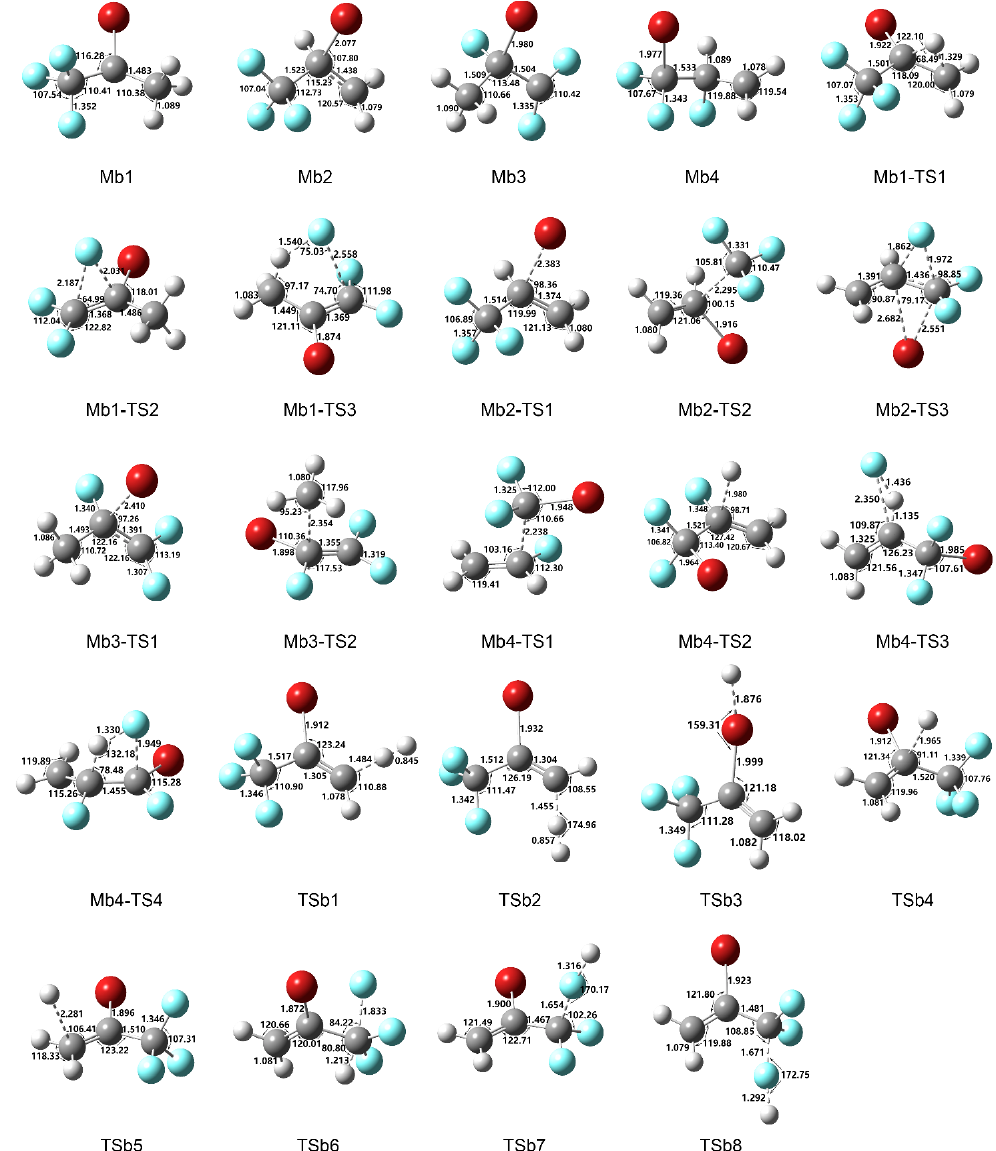
Figure 2. Optimized geometries of intermediates and transition states in 2-BTP + H reaction calculated at B3LYP/aug-cc-pVTZ. Bond lengths and angles are in angstrom and degree, respectively.